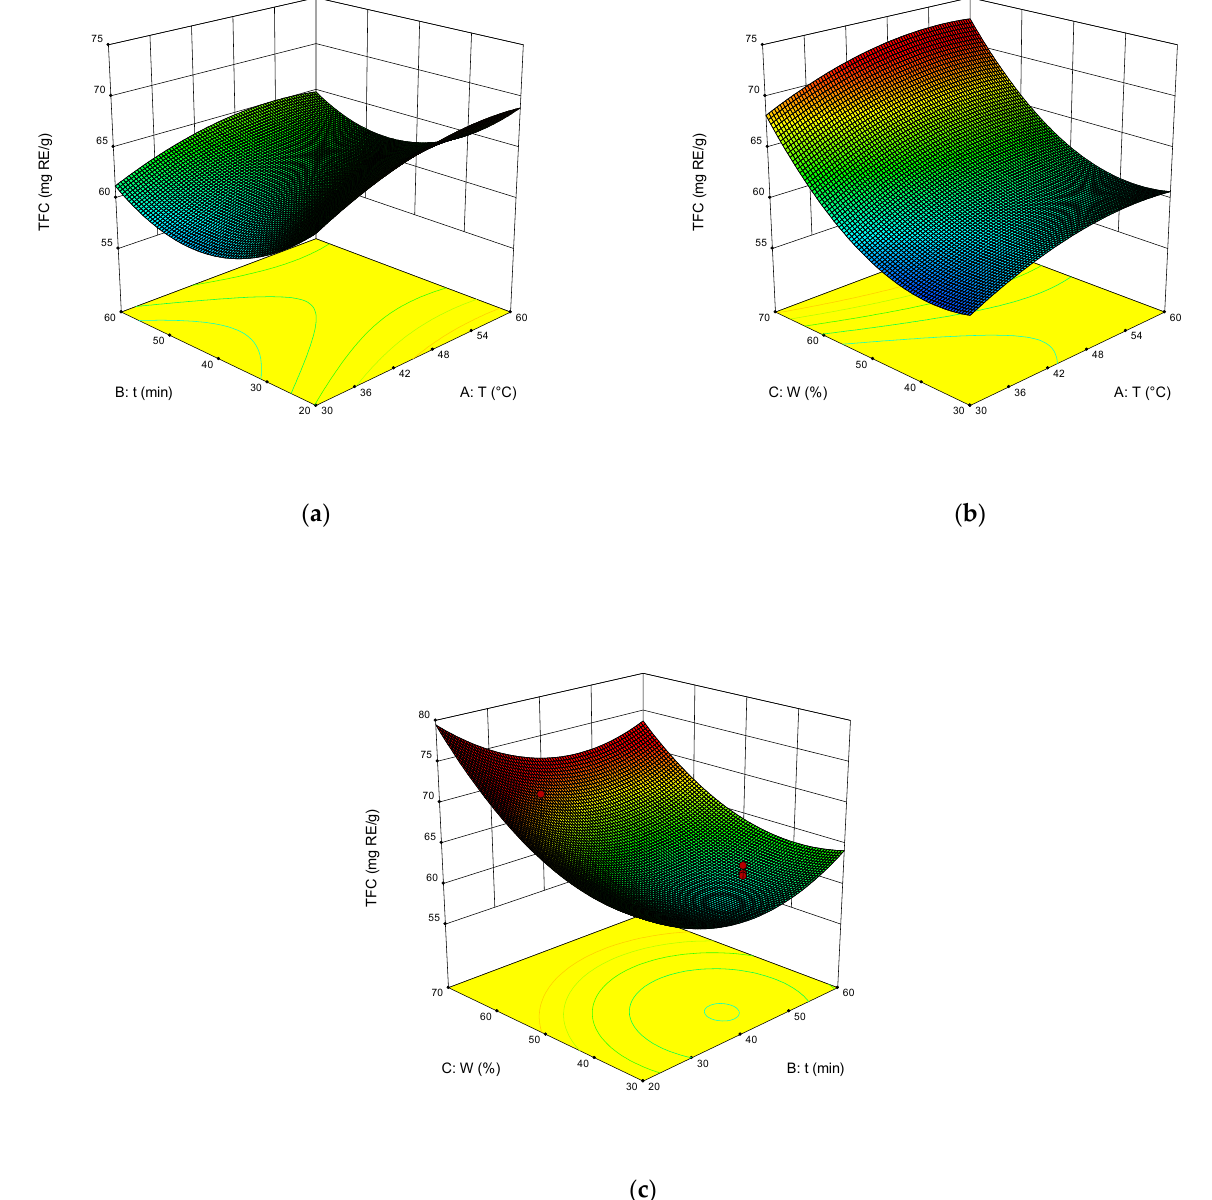
Figure 5. Response contour plots ( a – c ) showing the extraction temperature (A), extraction time (B), and water content (C) effect on the extraction yield of TFC.